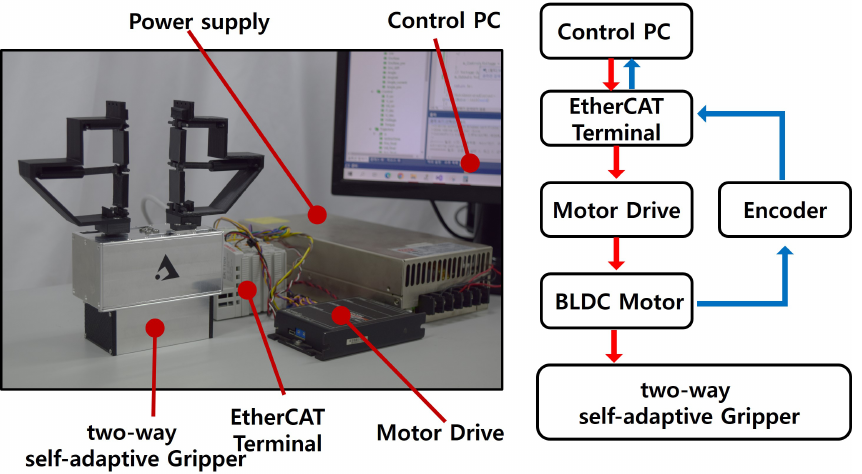
Figure 10. Hardware setup ( left ) and flowchart of the gripper system ( right